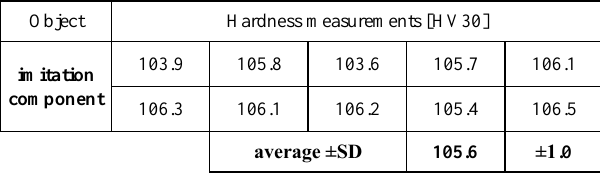
Table 4. Results of HV30 hardness measurements of snap hook from belts imitating the